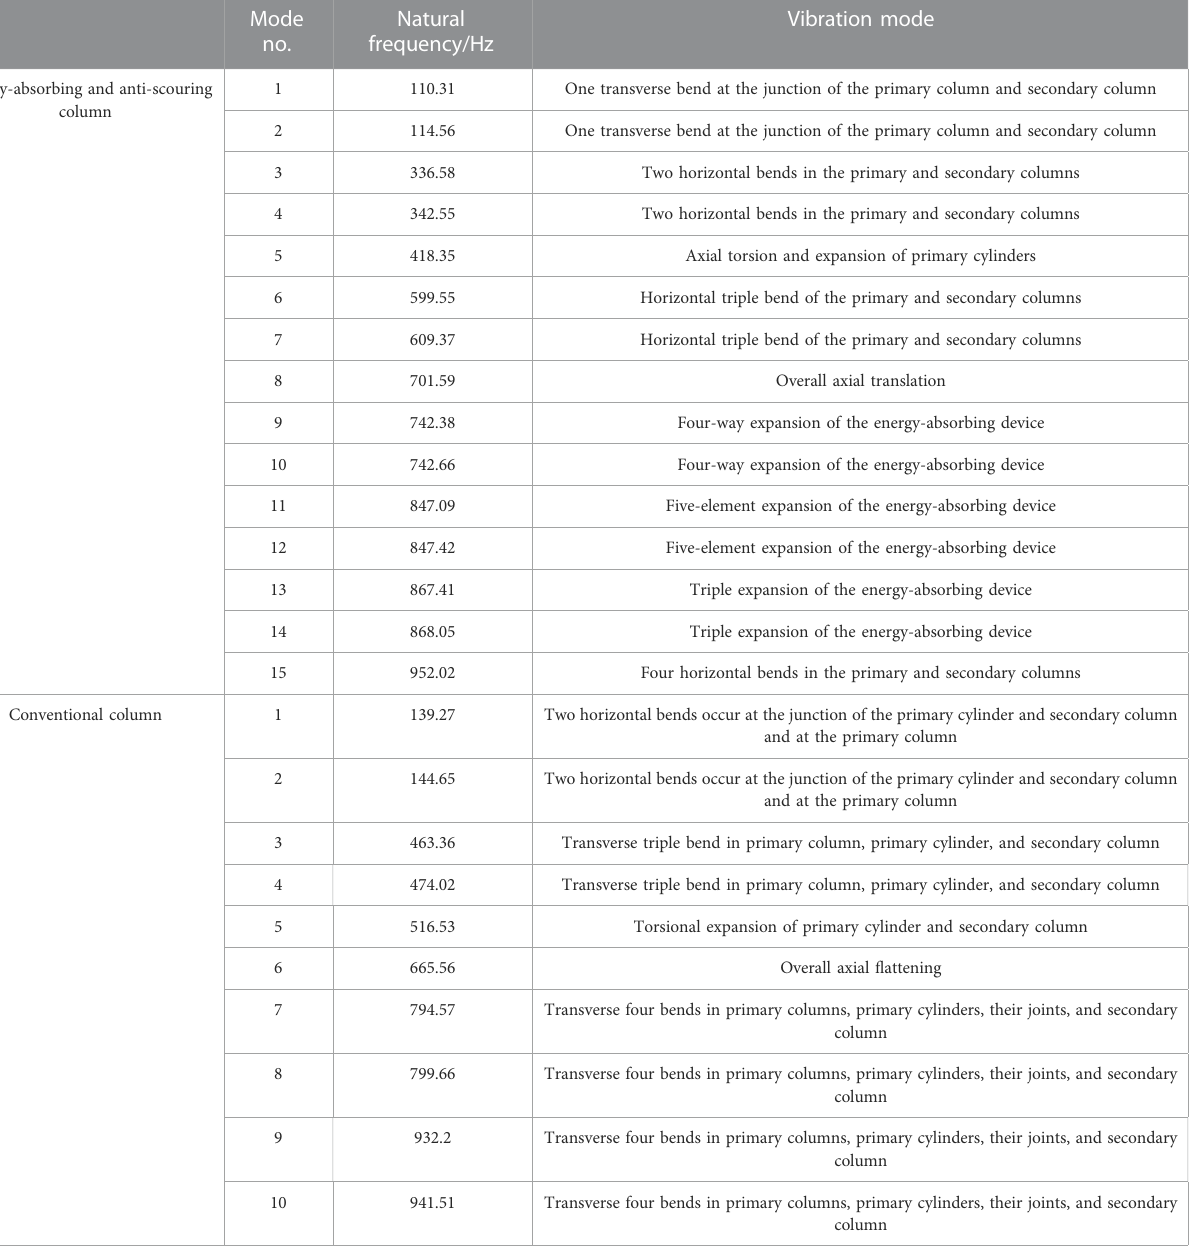
TABLE 9 Comparison of low-order natural frequencies and vibration mode characteristics of columns. Mode